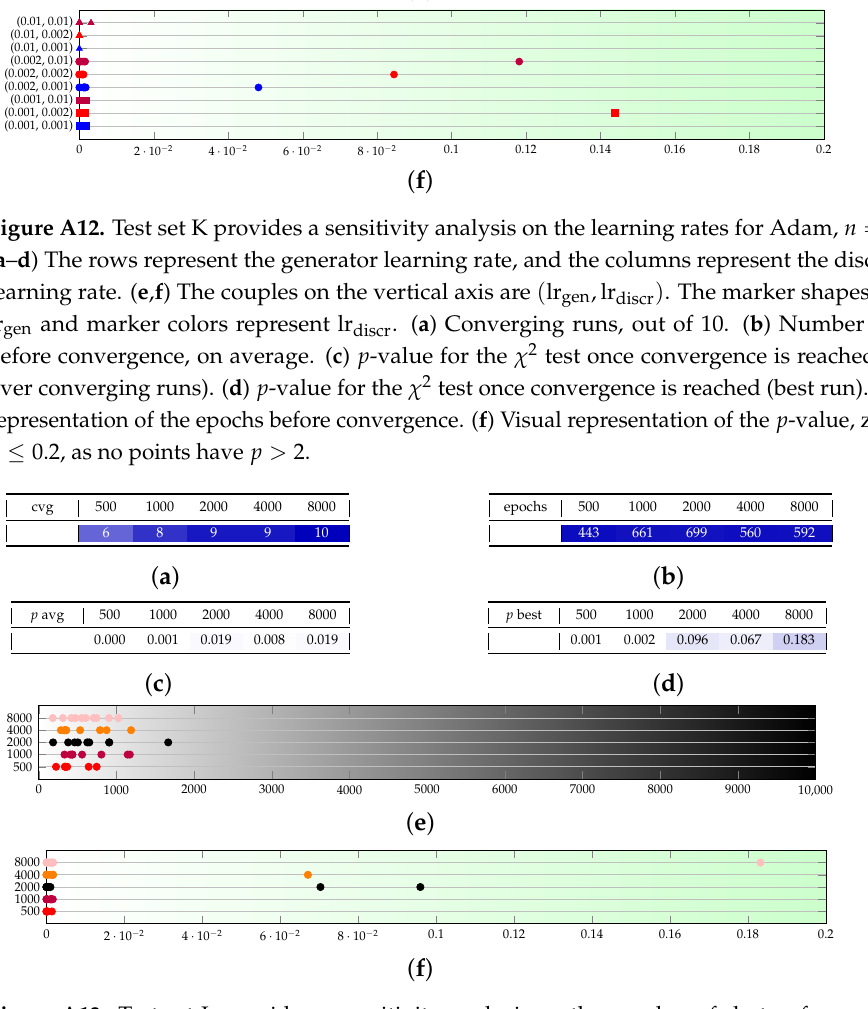
(c) p -value for the χ 2 test once convergence is reached (average (d) p -valueforthe χ 2 testonceconvergenceisreached(bestrun). over converging runs). 2000(0.001,0.001)(0.001,0.002)(0.001,0.01)(0.002,0.001)(0.002,0.002)(0.002,0.01)(0.01,0.001)(0.01,0.002)(0.01,0.01) 250 (e) Visual representation of the epochs before convergence.